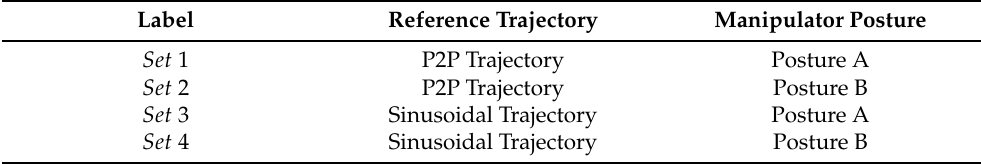
Table 1. Table of the experimental sets’ differentiation descriptions.